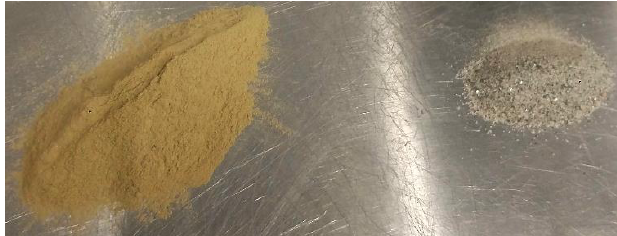
Figure 5. The appearance of used clogging agent: silt and sand.